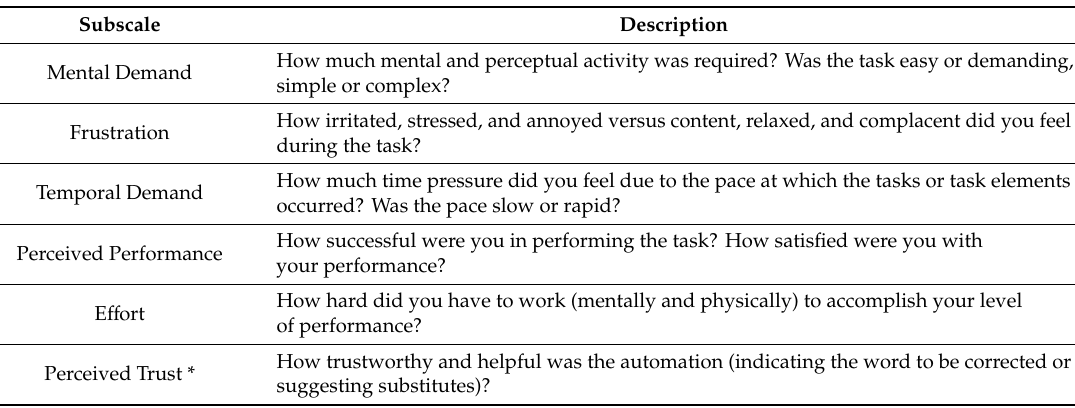
Table 1. Survey questions of National Aeronautics and Space Administration (NASA) Task Load Index (TLX) subscales and perceived trust on